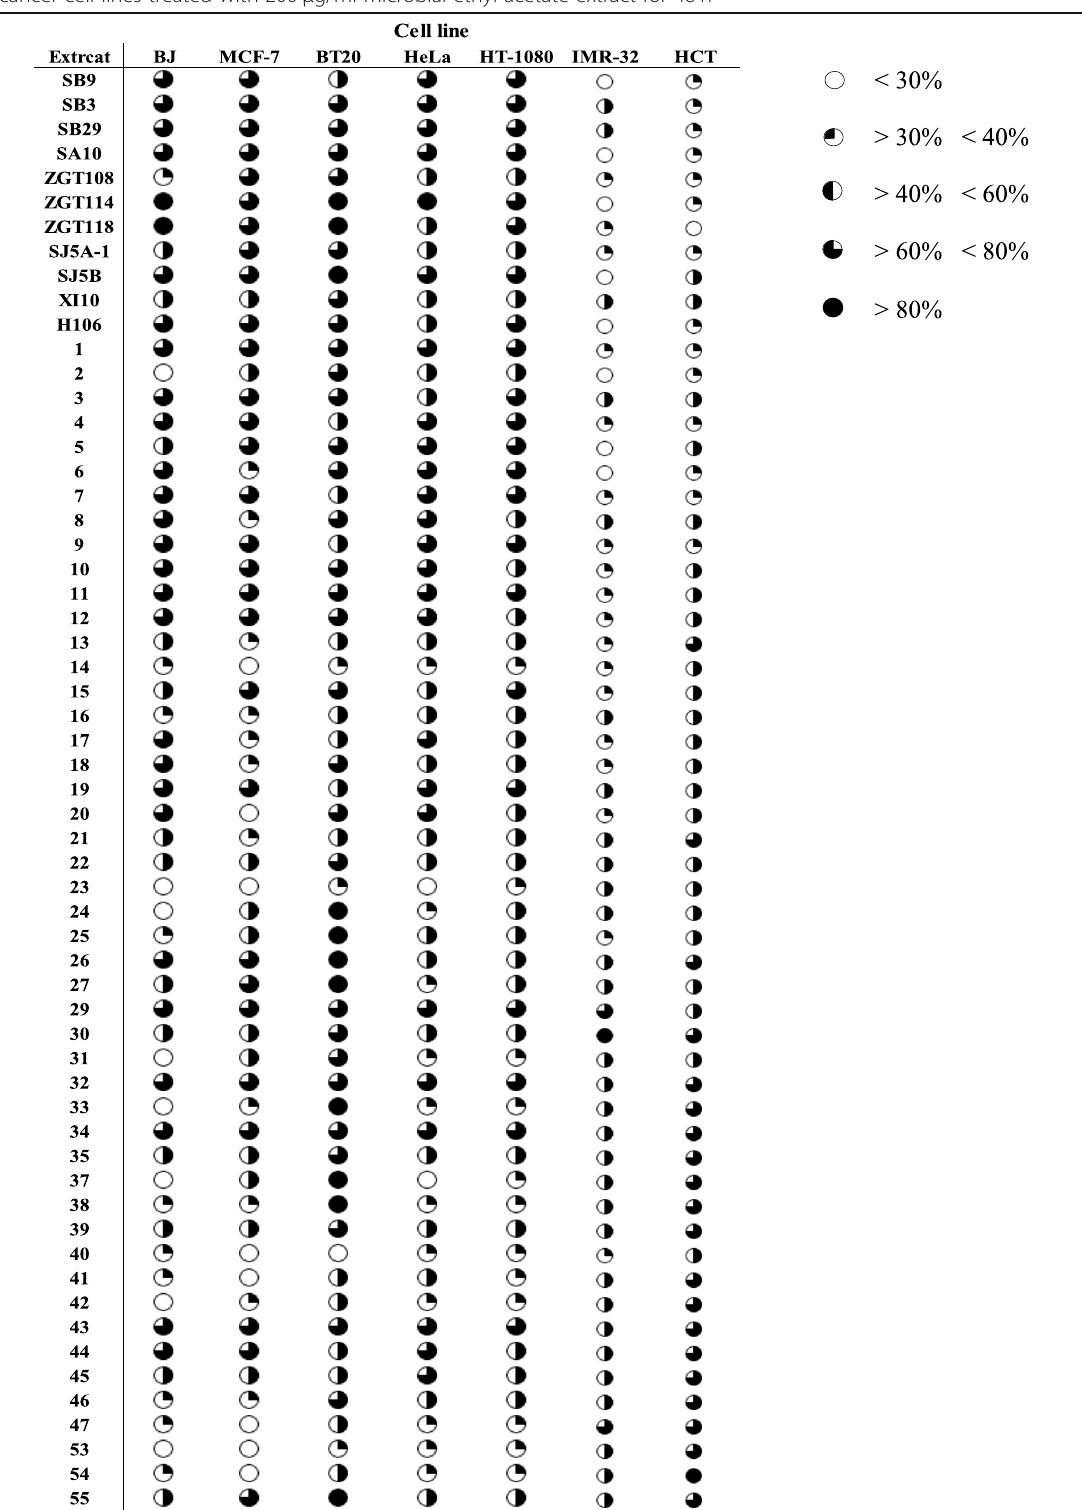
Table 2 The percentage growth inhibition of various cell lines after treatment with extracts. Growth inhibition of one normal (BJ) and six cancer cell lines treated with 200 μ g/ml microbial ethyl-acetate extract for 48